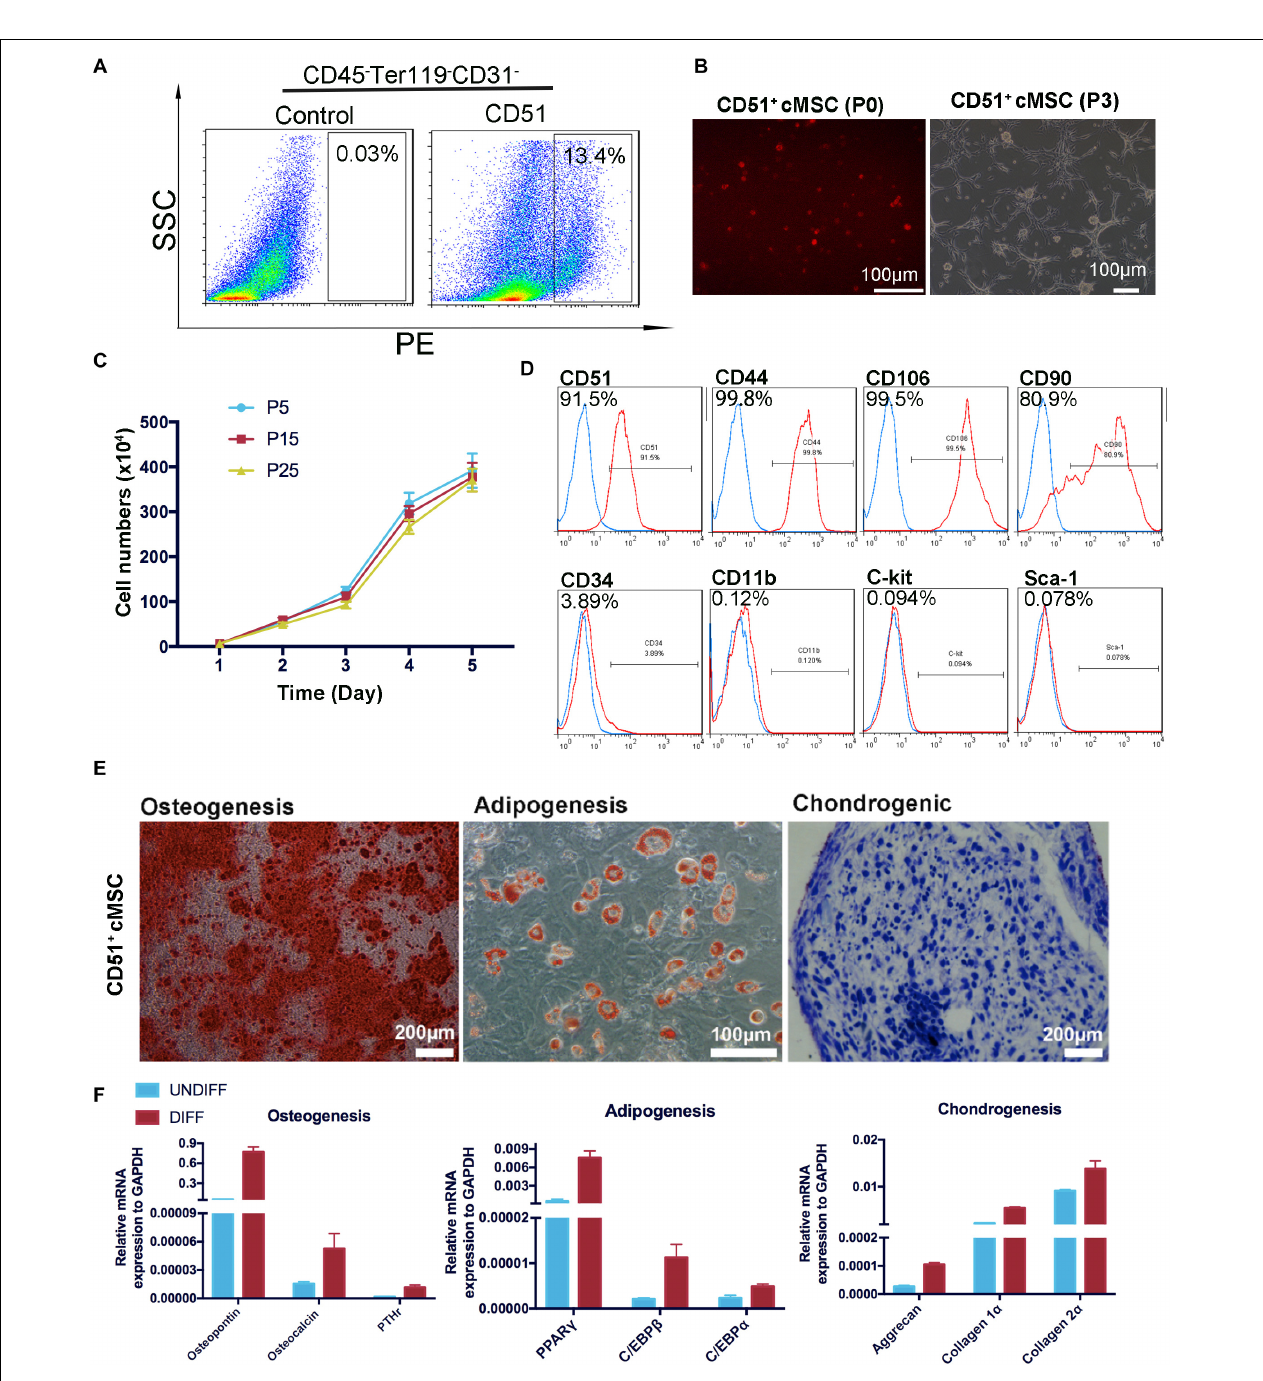
FIGURE 3 | Isolation and identification of CD51 + cMSCs. (A) Cardiac CD51 + CD45 − Terg119 − CD31 − cells were isolated by flow cytometry, 7-day-old neonatal mice (30 mice per time) were used, and the positive rate of CD51-positive cells in CD45 − Ter119 − CD31 − populations was about 13.4%. (B) Images of the freshly isolated or subcultured CD51 + cMSCs in plates: P0, passage 0; P3, passage 3. (C) Growth curves of CD51 + cMSCs in different passages (P5, P15, and P25), cell numbers were calculated daily for 5 days, and data were presented as mean ± SEM, n = 3. (D) Detection of MSC-related marker expression in the cultured CD51 + cMSCs (passage 5) using flow cytometry, the blue histogram was the negative control, and the right side of the red histogram indicated positive expression of the corresponding antibodies. (E) Multipotent differentiation of CD51 + cMSCs (passage 5), osteogenesis (Alizarin Red), adipogenesis (Oil Red O), and chondrogenesis (Alcian blue), and scale bars have been marked in the figure. (F) Differentiated CD51 + cMSCs were examined by quantitative PCR array to measure the specific genes of differentiated osteoblasts (osteopontin, osteocalcin, and PTHr), adipocytes (PPAR γ , C/EBP β , and C/EBP α ), and chondrocytes (aggrecan, collagen 1 α , and collagen 2 α ). Expression levels of each gene were compared to undifferentiated CD51 + cMSCs, data were normalized to GAPDH, and values were shown as the mean ± SEM, n = 3.